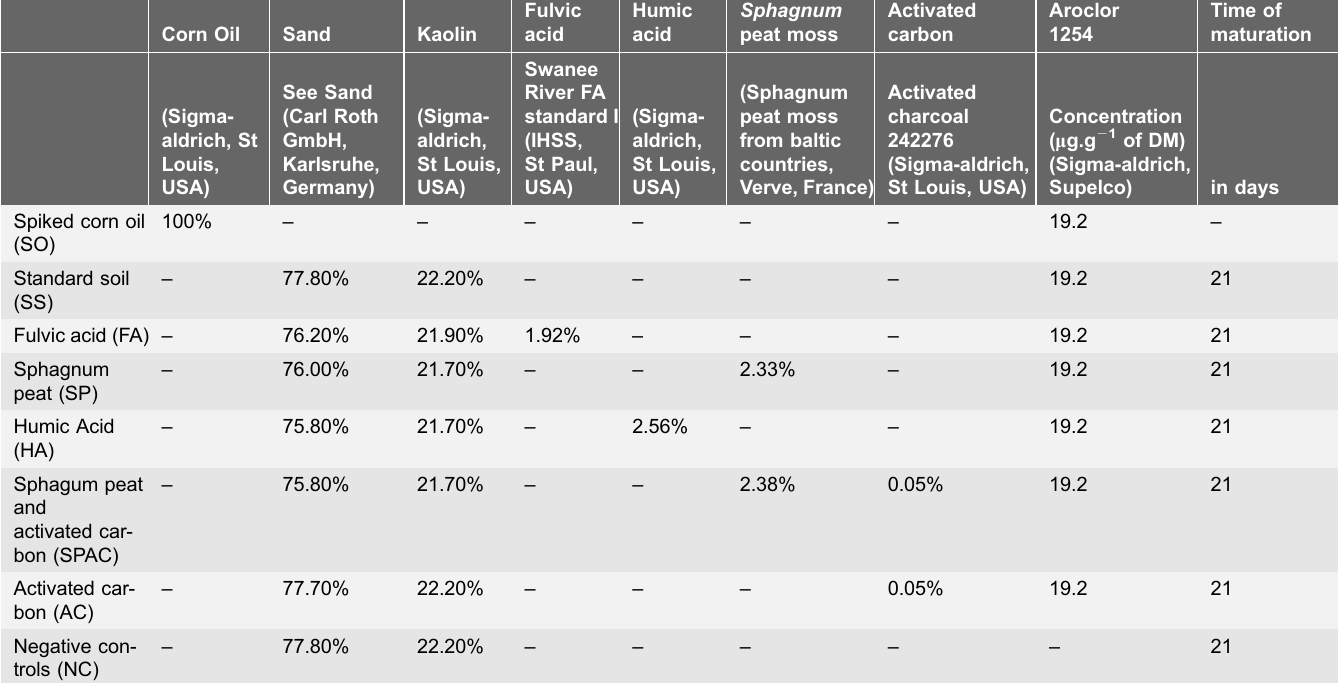
Table 1. Composition of the different artificial soils and treatment of the